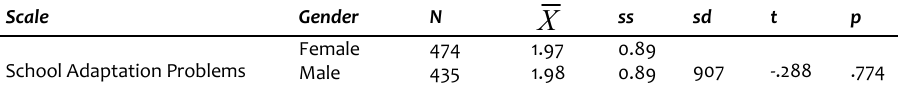
Table 4. T Test Results Concerning Primary School Students' School Adaptation Problems According to